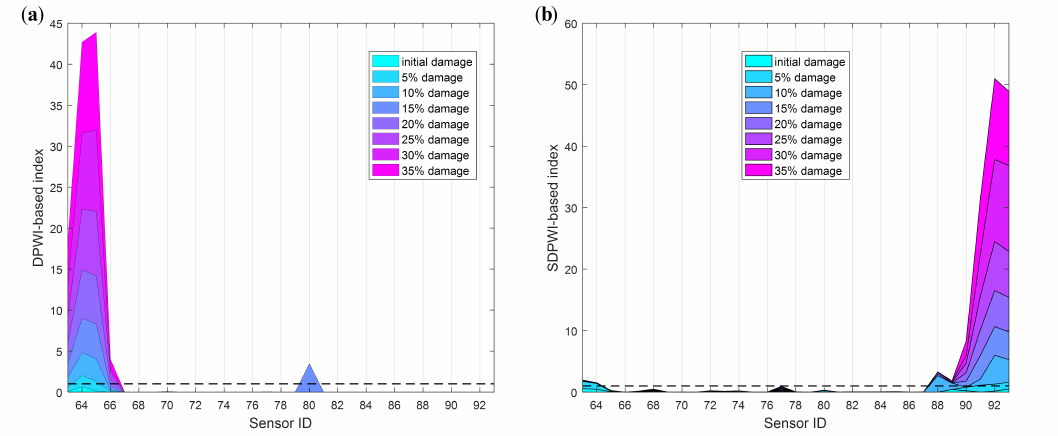
Figure 22. Damage identification results using first 5 singular values: ( a ) Damage I; ( b ) Damage